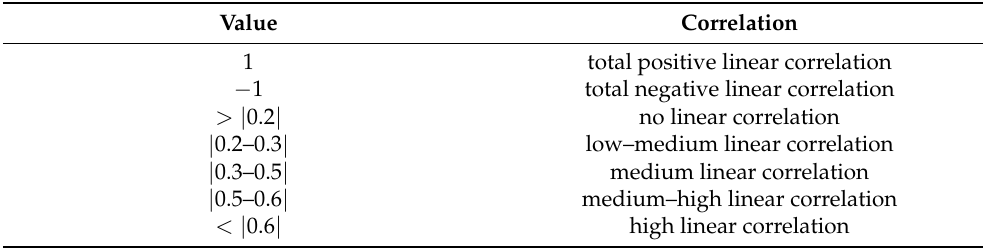
Table 3. PCC values and correlation.